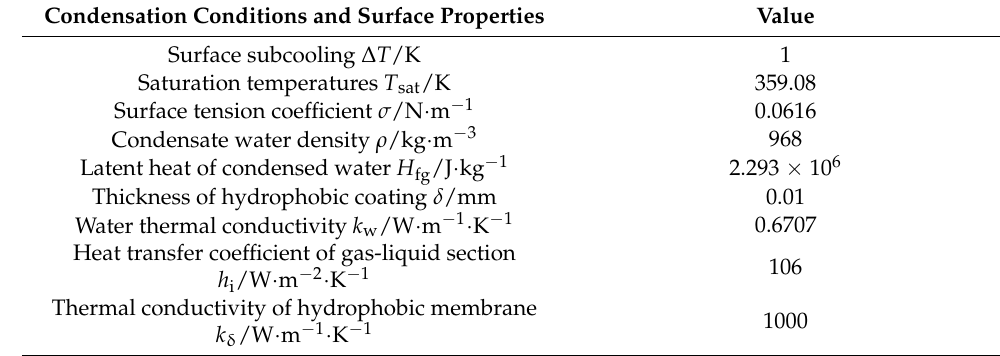
Table 1. Simulation parameters. Condensation Conditions and Surface